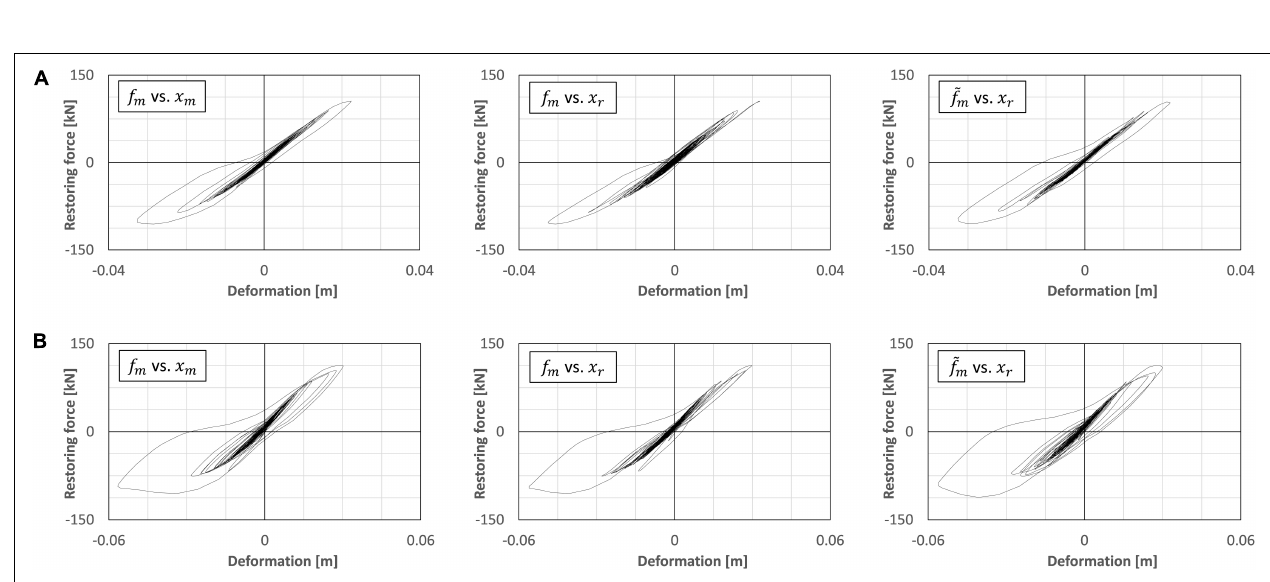
FIGURE 11 | Hysteresis of restoring force vs. deformation of RC column specimen. (A) f c = 0.2 Hz, El Centro NS 50%. (B) f c = 0.2 Hz, El Centro NS 80%.